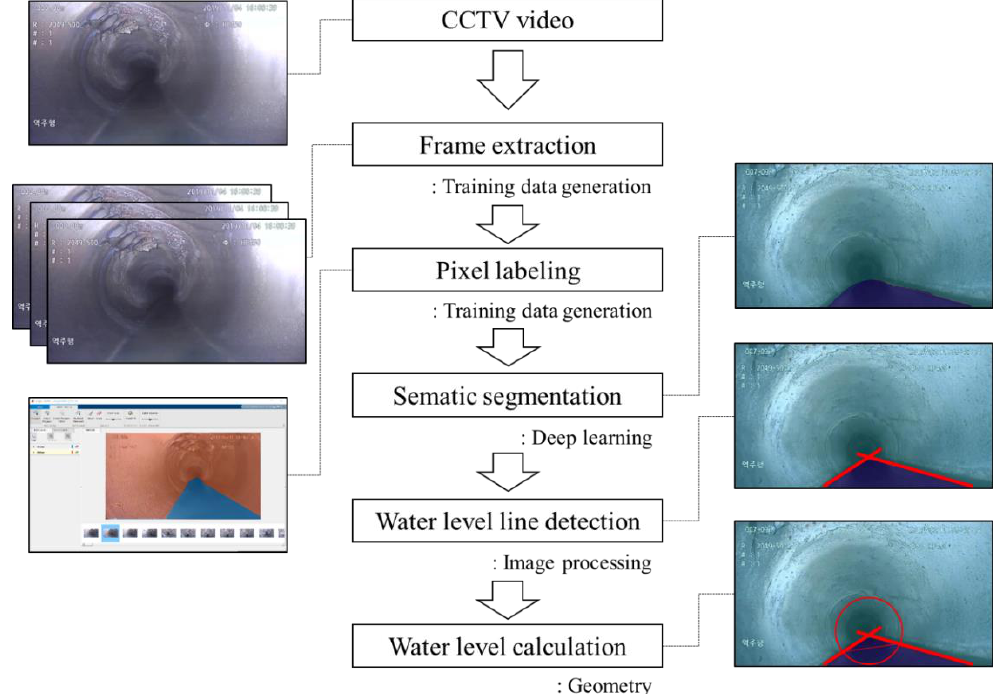
Figure 1. Process to determine water level from sanitary sewer CCTV inspection footage.